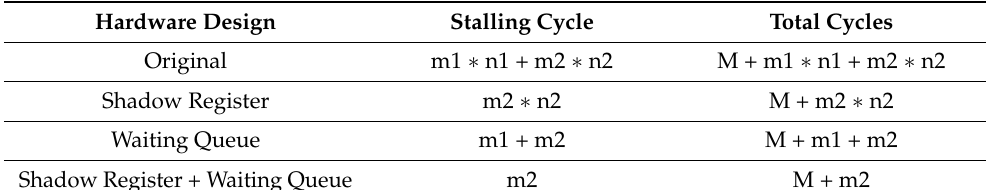
Table 1. Theoretical cycle consumption under different designs. Assuming that the number of instructions is M, the number of WAW hazard is m1, the WAW extra cycle cost is n1, the number of RAW is m2 and the RAW extra cycle cost is